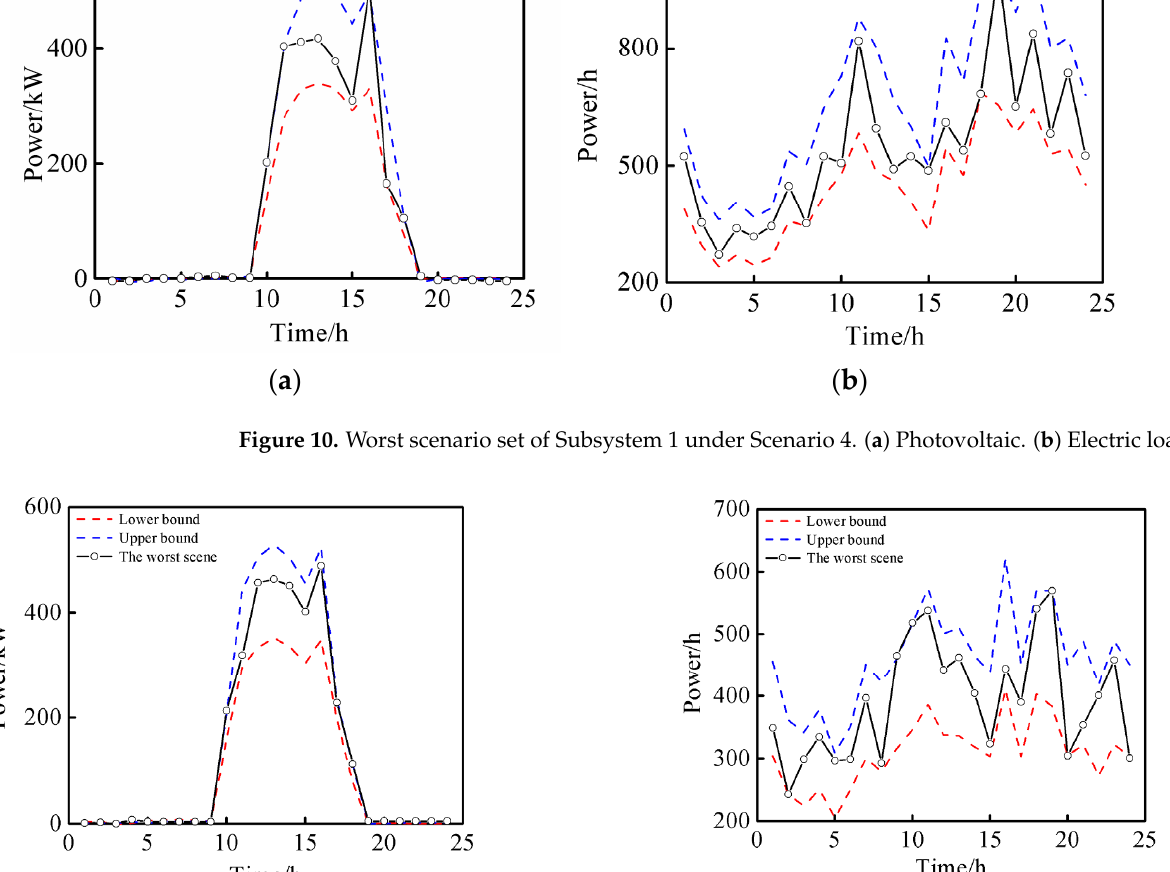
Figures 10–12 show the worst source load robust scenario sets of the three IESs: